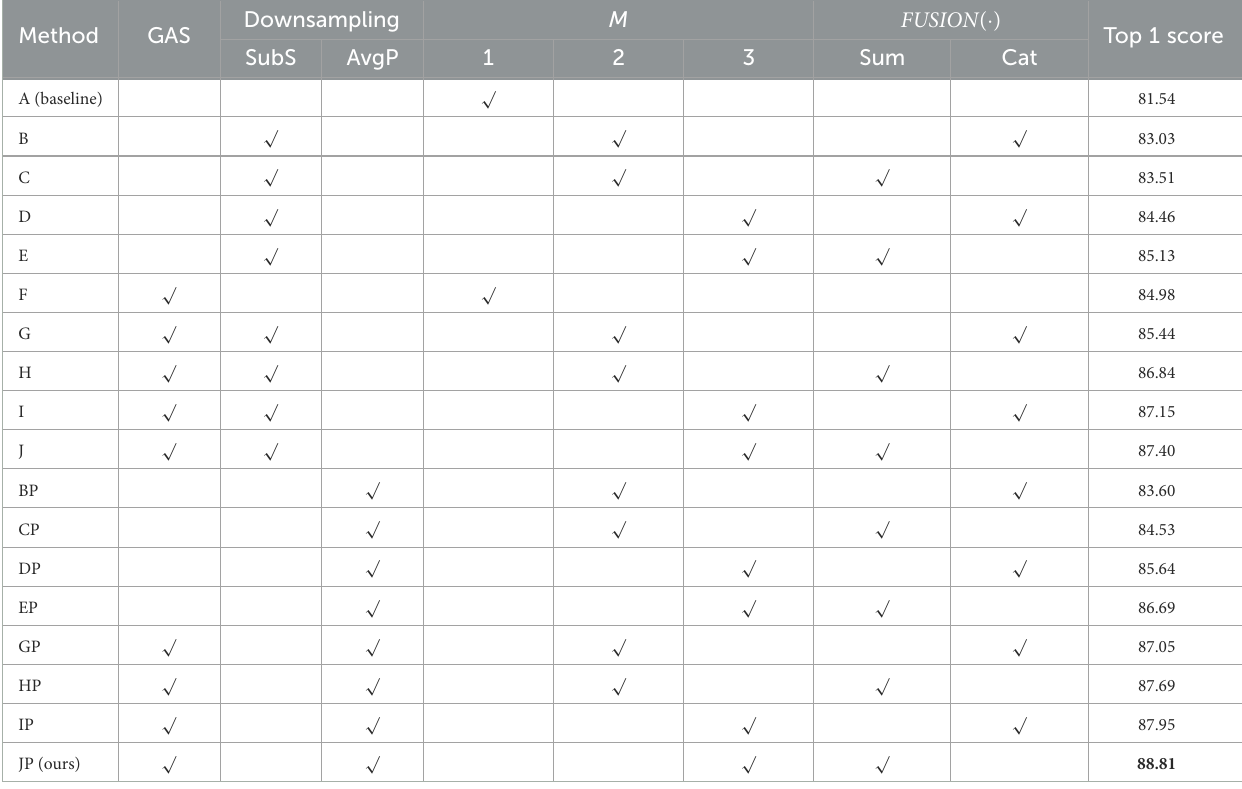
TABLE 3 Ablation study of the proposed GAS and MTS-3DCNNs in terms of top 1 score ( % ) on the MTS-STAG dataset.